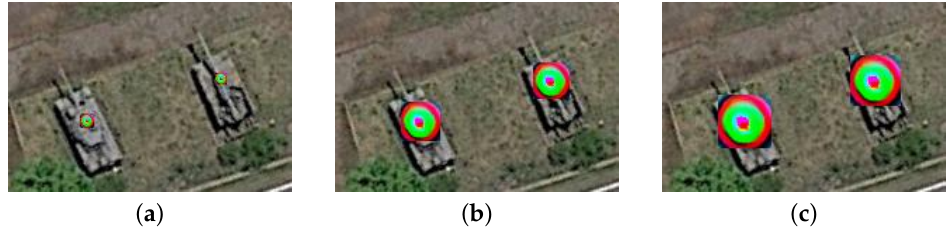
Figure 12. Adversarial patch with a size of ( a ) 10%, ( b ) 30%, ( c ) 40% of the maximum length and width of the detection target.